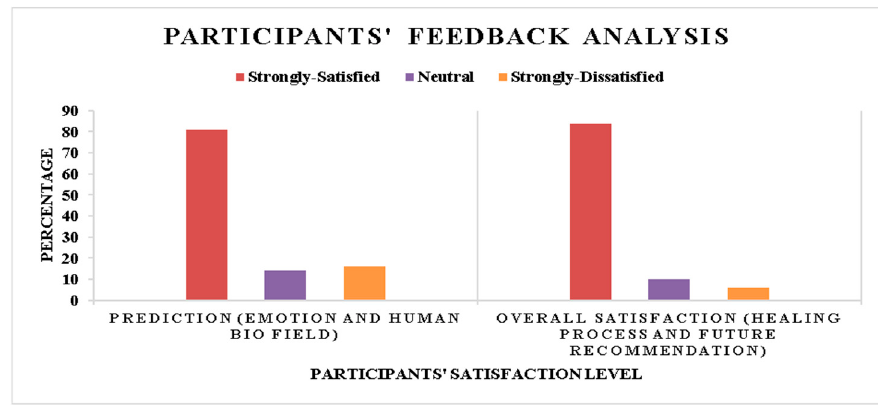
Figure 11. Participant feedback analysis based on the satisfaction level.